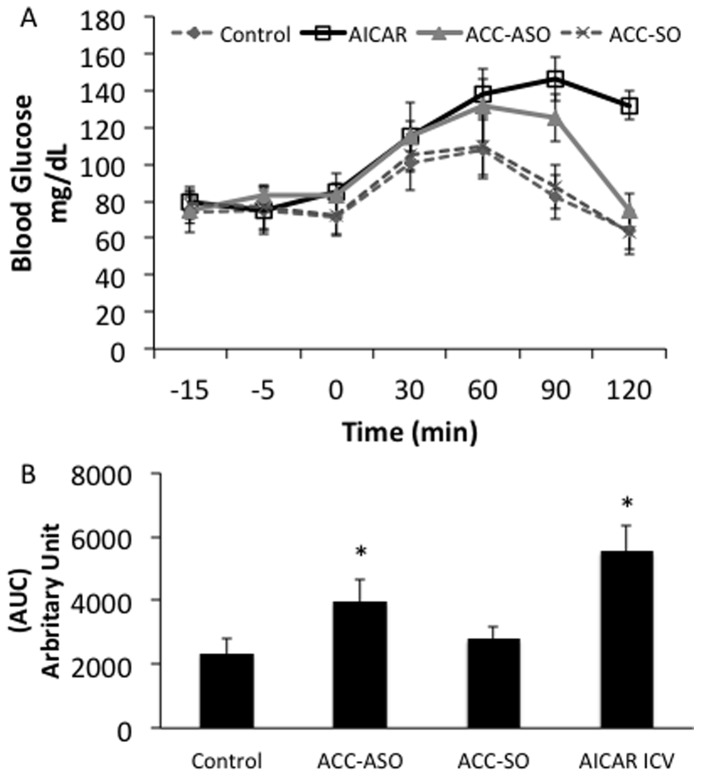
Liver glucose production after challenge with pyruvate in ASO-ACC and ACC-SO mice.Blood glucose during pyruvate test (A) and area under curve (AUC) (B). Data are means ± SEM of 8–10 rats. *p≤0.05 vs. control and SO rats.